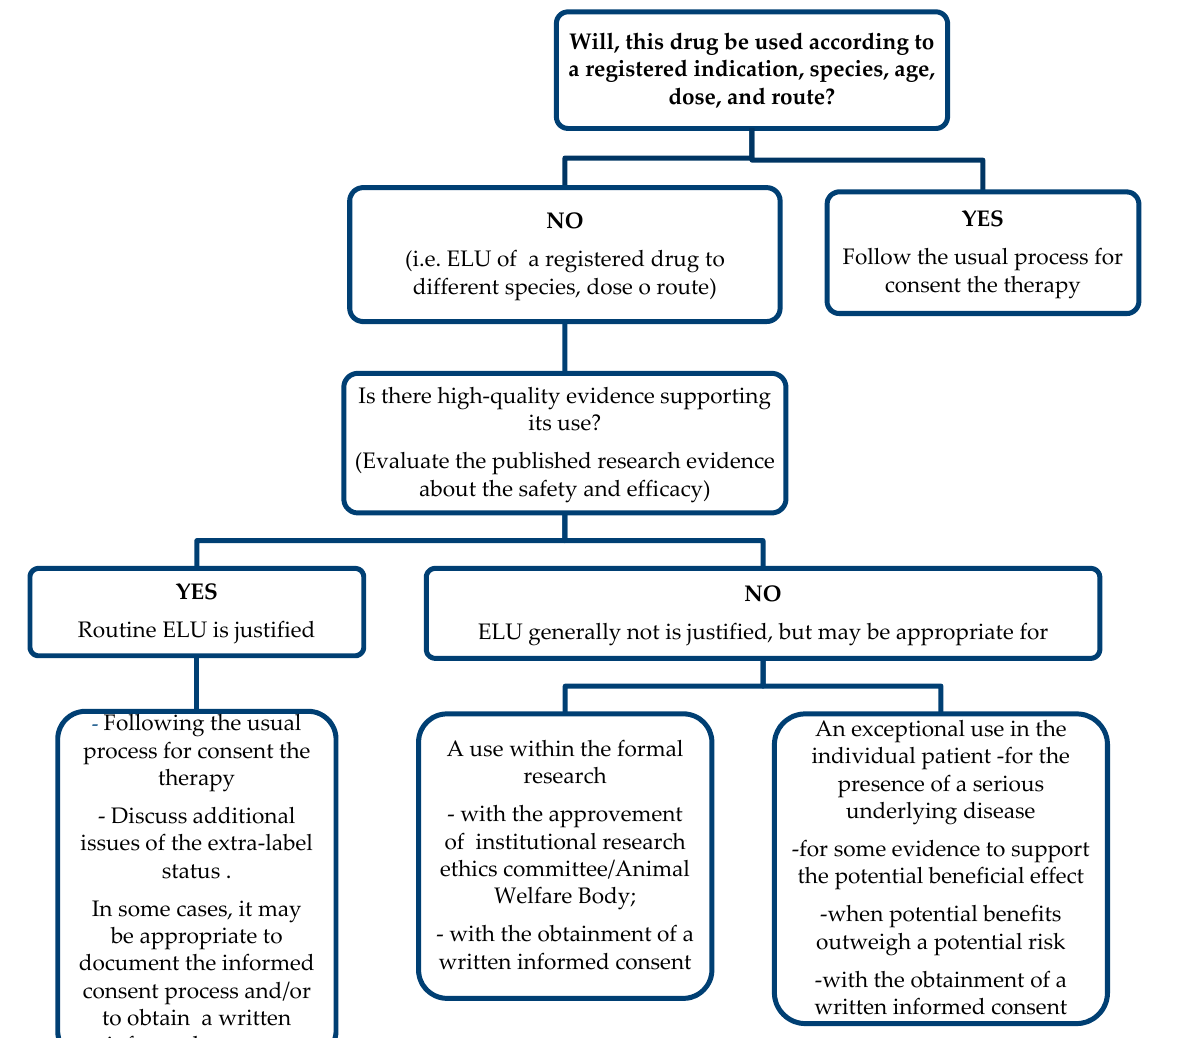
Figure 2. Evaluating the appropriateness of extra-label use (ELU) in dogs.